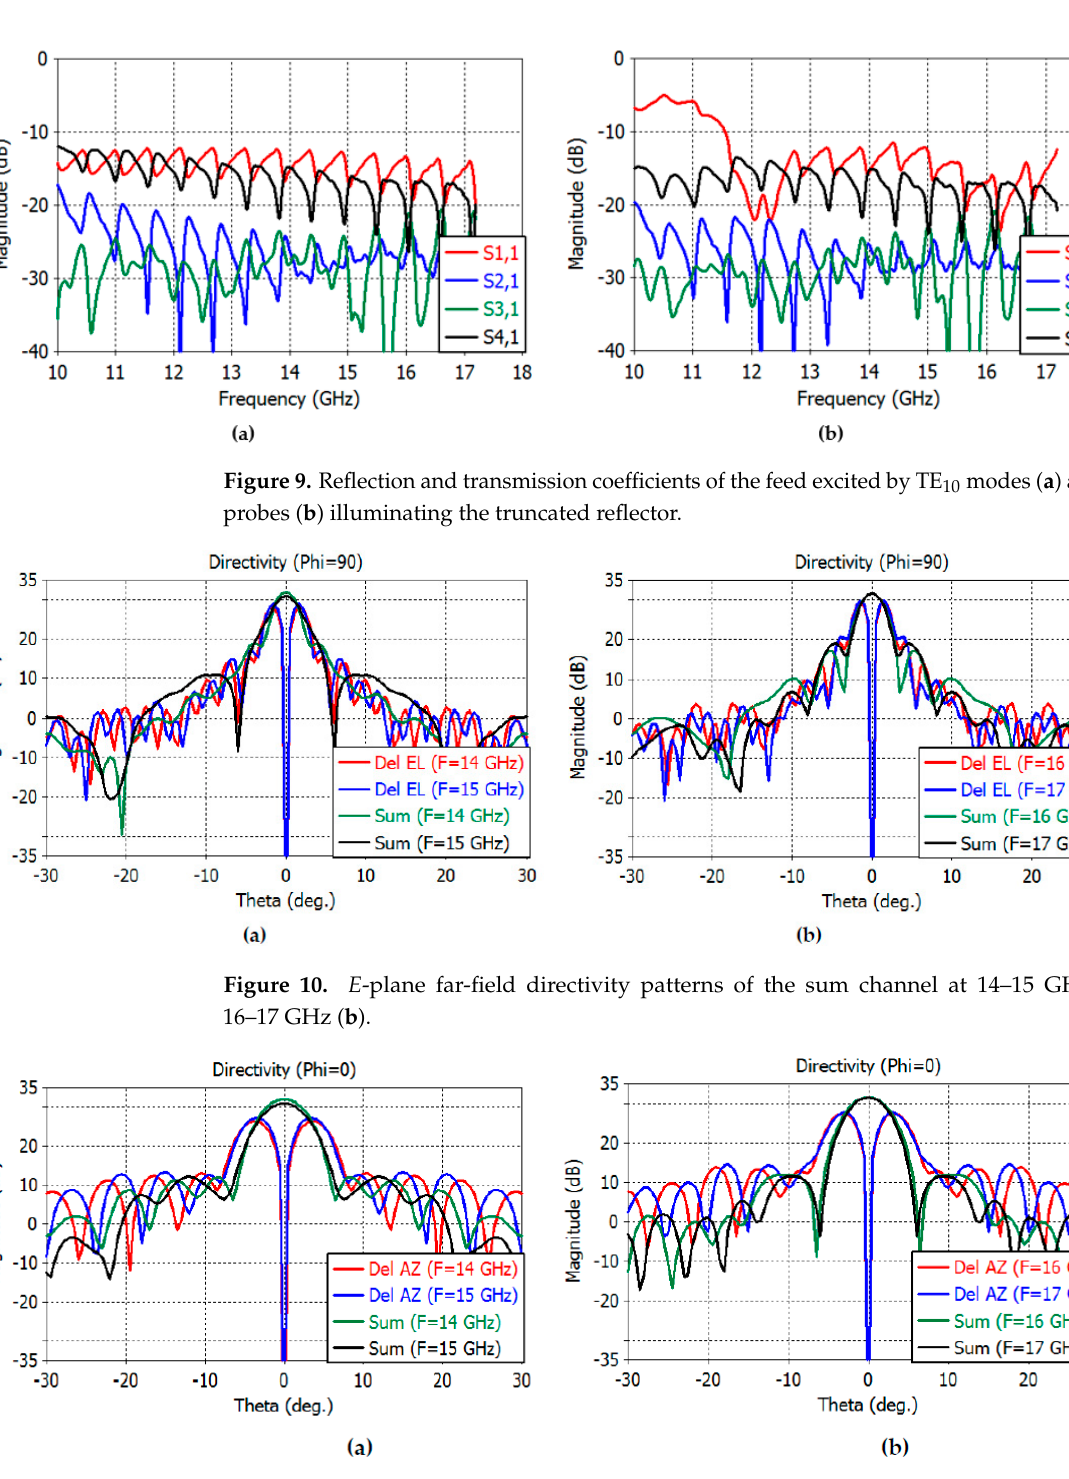
Figure 9. Reflection and transmission coefficients of the feed excited by TE 10 modes ( a ) and by coax- ial probes ( b ) illuminating the truncated reflector.